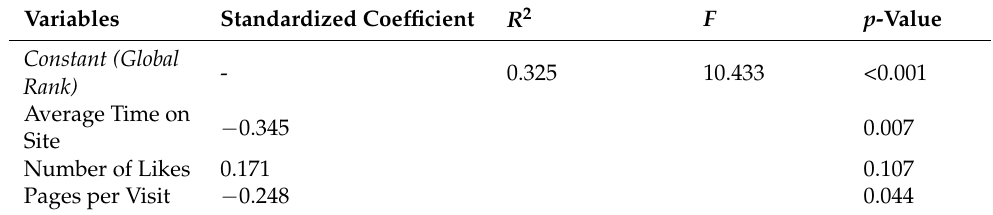
Table 11. Regression analysis for